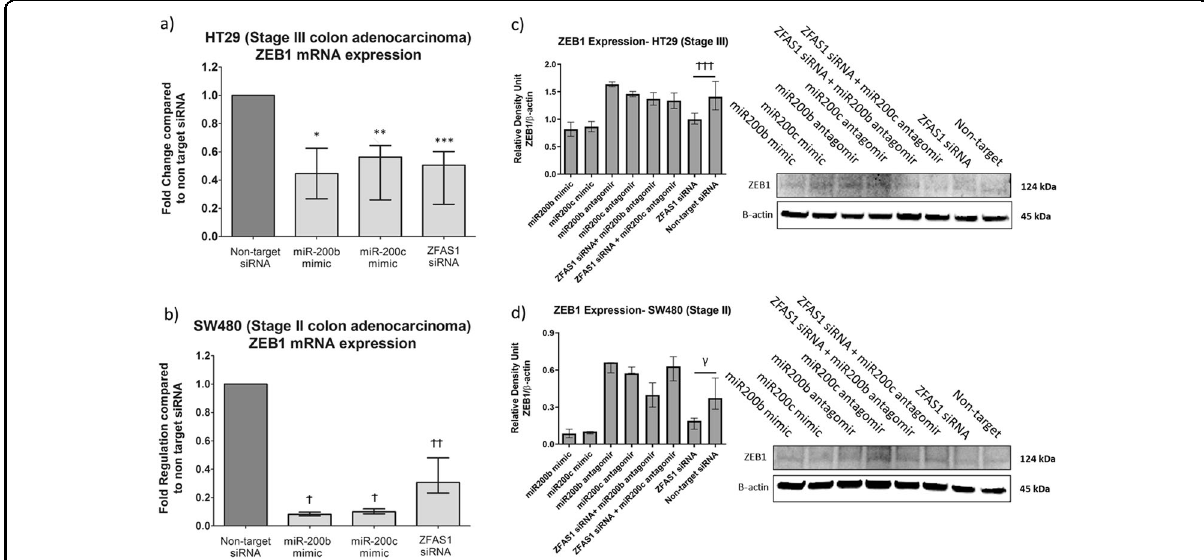
Fig. 4 ZFAS1 knockdown is associated with changes in ZEB1 expression. This effect is reversed by dual knockdown of ZFAS1 and miR200b or with ZFAS1 and miR200c. a In the HT29 cell line, ZFAS1 knockdown (FR = − 2.68, * p = 0.031), miR-200b mimics (FR = − 3.19, ** p = 0.03), or miR-200c mimics (FR = − 1.82, *** p = 0.04) leads to decreased ZEB1 mRNA expression using RTqPCR ( n = 6 replicates). b In the SW480 cell line, ZFAS1 knockdwon (FR = − 3.37, Ϯ p = 0.034), miR-200b mimics (FR = − 12.24, Ϯ p < 0.001), or miR-200c mimics (FR = − 10.1, ϮϮ p < 0.001) knockdown leads to decreased ZEB1 mRNA expression using RTqPCR ( n = 6 replicates). c There is signi fi cantly decreased ZEB1 protein expression with ZFAS1 knockdown ( ϮϮϮ p = 0.046) in the HT29 cell line by Western blotting. This effect was reversed by dual knockdown of either ZFAS1 and miR200b or ZFAS1 and miR200c (both p > 0.05). As expected, miR200b and miR200c antagomirs increased ZEB1 expression, with reciprocal decreased in ZEB1 expression with miR-200b and miR200c mimics ( n = 5 replicates). d Similarly, there is signi fi cantly decreased ZEB1 protein with ZFAS1 knockdown in the SW480 cell line by Western blotting ( γ p = 0.047). This effect was reversed by dual knockdown of either ZFAS1 and miR200b or ZFAS1 and miR200c (both p > 0.05). As expected, miR200b and miR200c antagomirs increased ZEB1 expression, with reciprocal decreased in ZEB1 expression with miR-200b and miR200c mimics ( n = 5